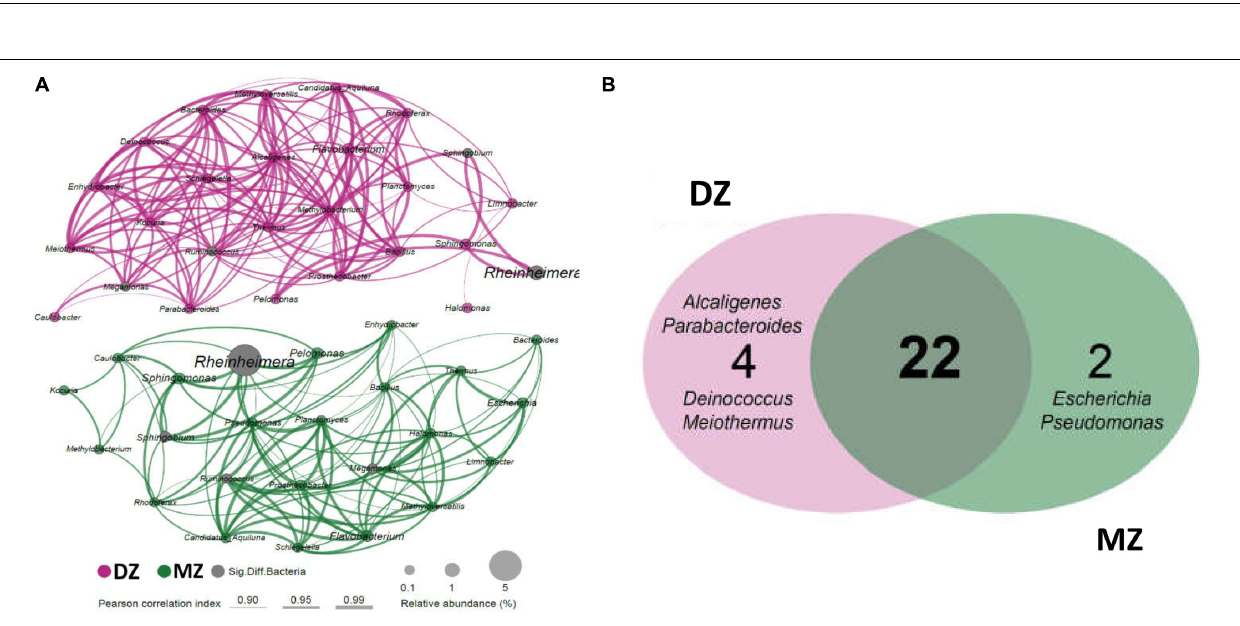
FIGURE 4 | Bacterial co-occurrence networks of DZ and MZ pairs. (A) Each node in the network indicates a bacterial genus. Node size represents the average relative abundance of one genus in each twins group. The thickness of edges represents the correlation value. Only the bacterial connections (edges) larger than cut-offs (correlation value r > 0.9, p < 0.05) were shown. (B) Shared and unique genera between networks of the two groups. Twenty-two genera present in at least 50% of all samples of each group were shared by the two groups, and 2 and 4 genera were unique in MZ and DZ pairs,